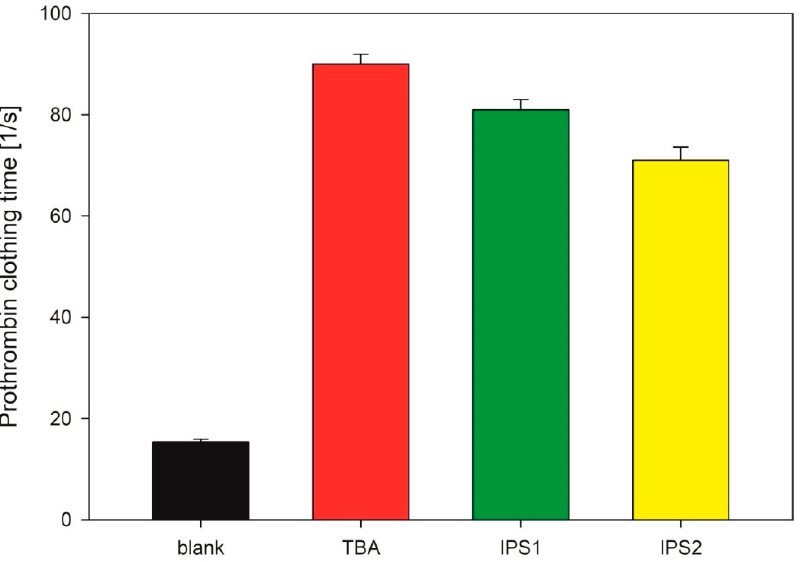
Figure 3. Fibrinogen clothing time measured in the presence of thrombin aptamers. Conditions: 10 mM PBS, 2 nM thrombin, 20 nM DNA, 1 µM fibrinogen.